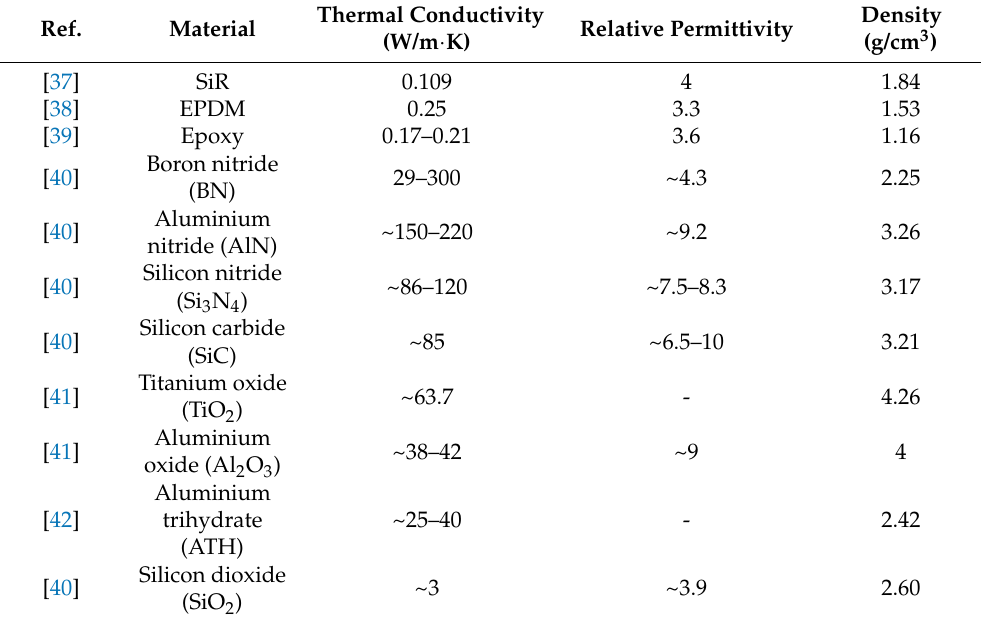
Table 1. Polymeric materials used for outdoor high-voltage insulators and specified properties of